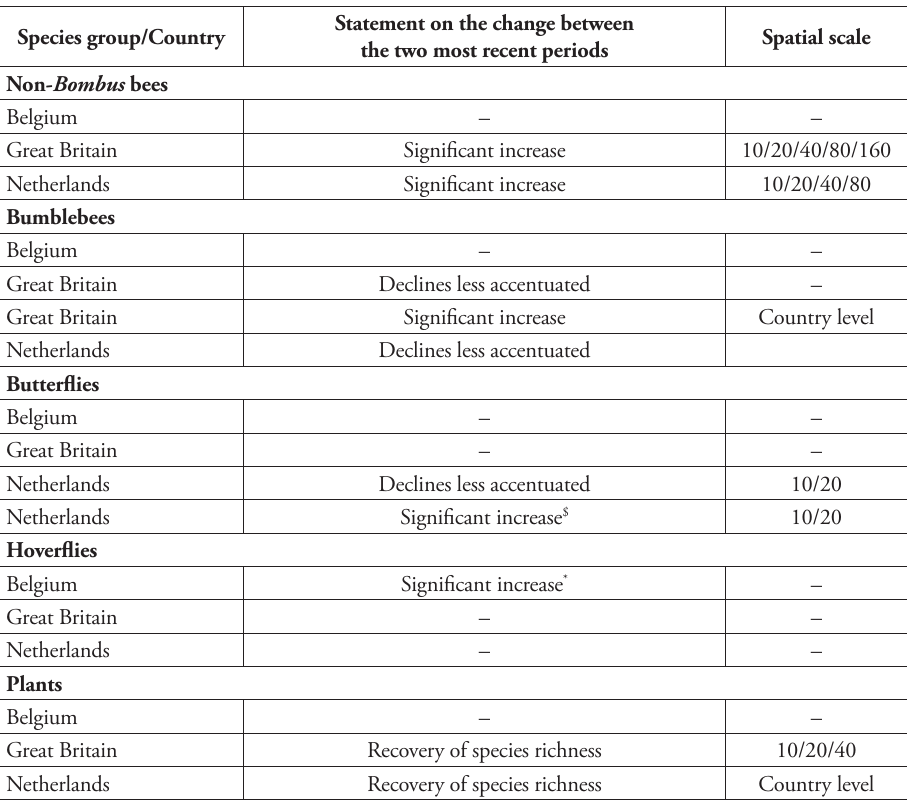
Table 1. Statements in CA2013 supporting a slowing down of species richness decline. The column with spatial scales to which a statement applies lists either the grid sizes (as length of a grid side in km) or the country level. $: The changes on Figure 1 and in Table S2 are in fact decreases. *: It is unclear if this result is interpreted as a slowing down of the decline, since no significant change between the first two periods is reported. For all other groups with statements, a decline in an earlier period is